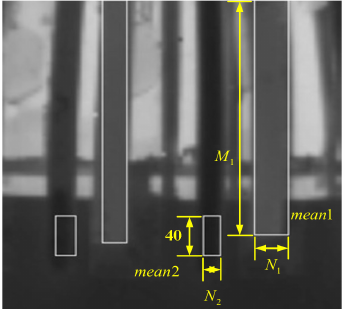
Figure 14. Illustration of the calculation method for the infrared feature D .